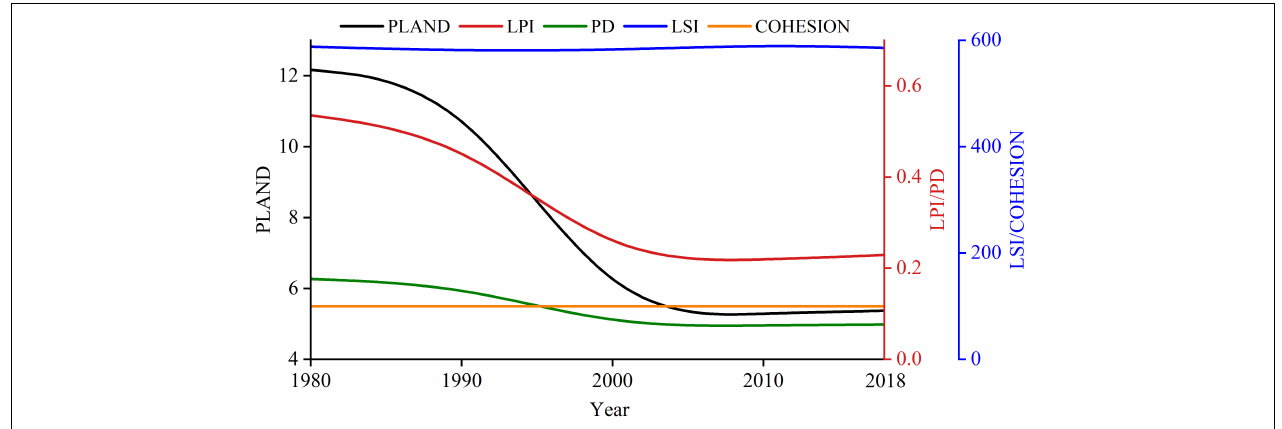
FIGURE 6 | Trends in the ecological security landscapes index, 1980–2018.